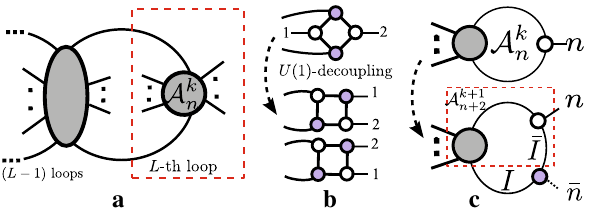
Fig. 1 a Obtaining the L th loop amplitude recursively. b Utilizing the U ( 1 ) decoupling relation to turn a nonplanar diagram into a planar